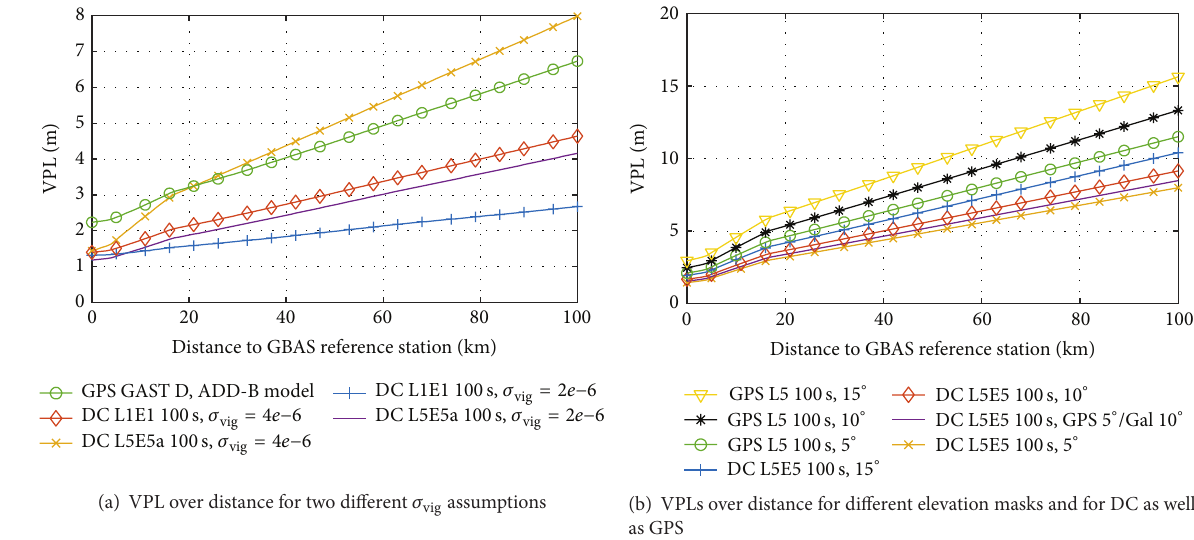
Figure 16: Comparisons of H0 VPL over distance for changing elevation mask and 𝜎